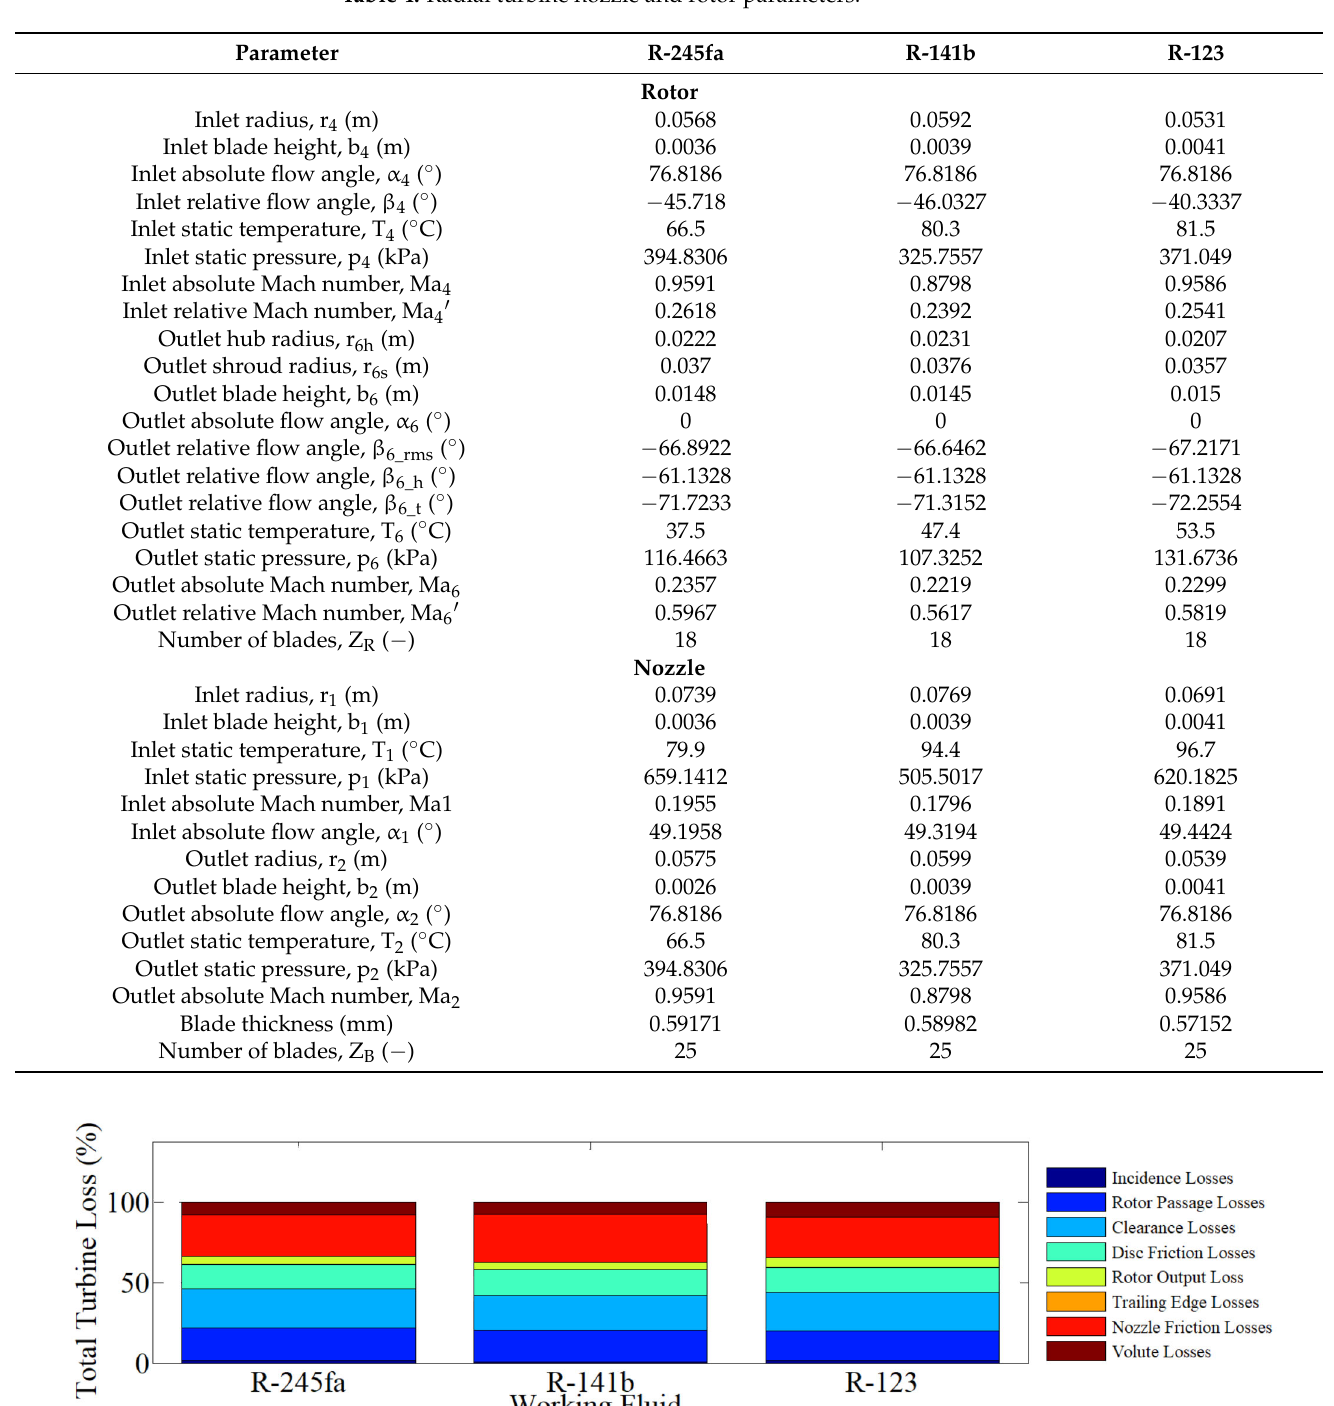
Table 4. Radial turbine nozzle and rotor parameters.